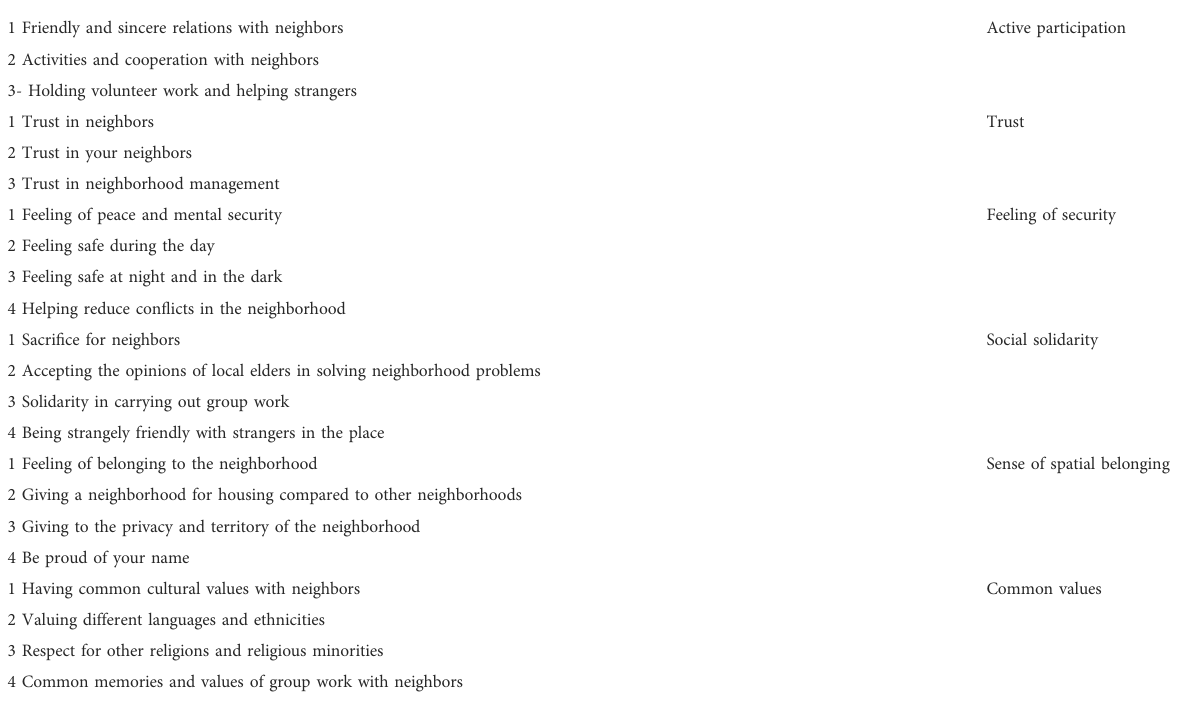
TABLE 1 Operational de fi nition of indicators related to social capital variable (Source: